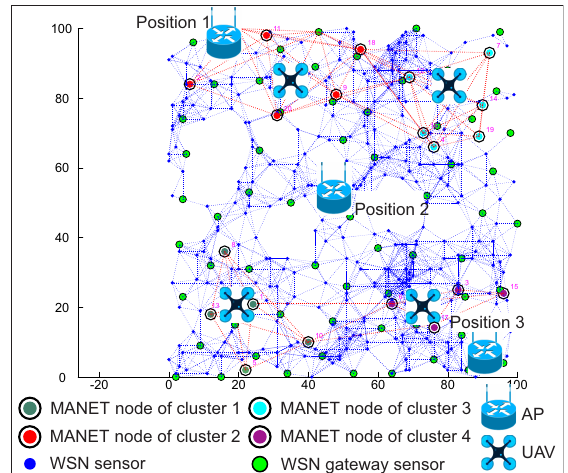
Figure 17. Example of simulation scenario 2 with the positions of AP, WSN, MANET and UAV